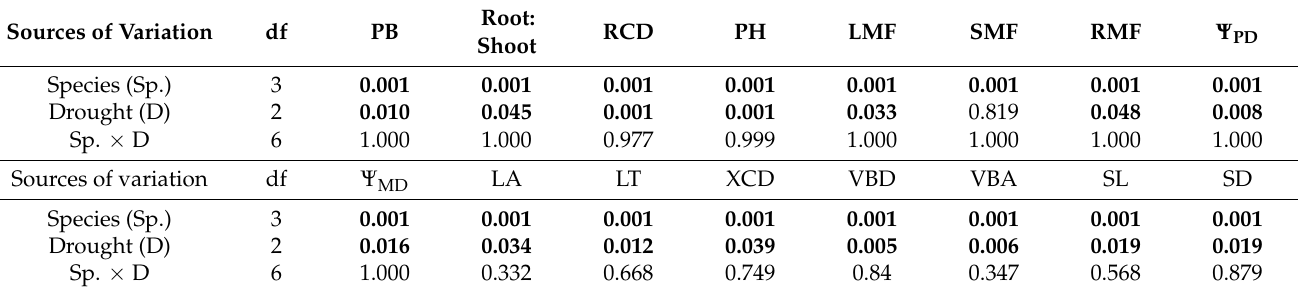
Table 1. ANOVA results for tree species, drought intensities, and their interaction effects on leaf morphological and anatomical traits, stem water potentials, and biomass allocation patterns of two- year-old seedlings of Larix gmelinii and Pinus koraiensis (gymnosperms) and Fraxinus mandshurica and Tilia amurensis (angiosperms), at three drought levels (i.e., severe drought, SD, ≤ 5%; moderate drought, MD, 6–10%; well-watered, WW, 16–20%) in NE China. Abbreviations, PB: plant